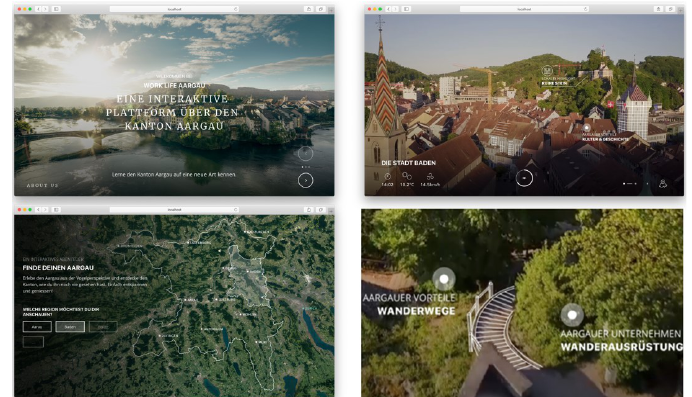
Figure 2 . A few selected screenshots from the interface. The landing page (top left), the geographic overview (bottom left), oblique fly- through (top right), ‘details on demand’ close-up (bottom right). White-line or checkerboard patterns, e.g., as overlain on the tower at the right side of the image highlight objects of interest. Points of interest (POIs) are labeled and marked as white dots, which can be